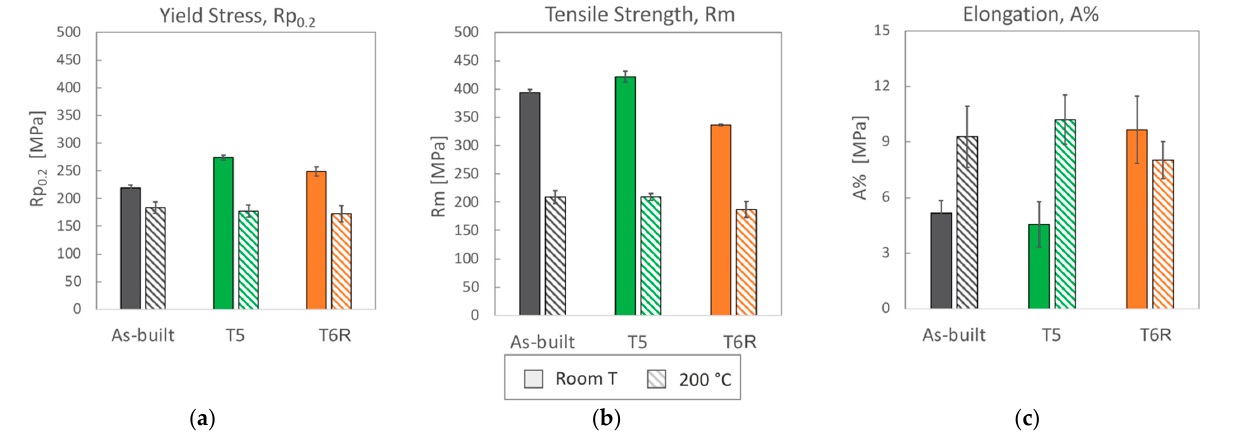
Figure 4. ( a ) Yield stress, ( b ) tensile strength, and ( c ) elongation to failure (mean value and standard deviation) obtained from tensile tests performed at room and high (200 °C) temperature for the as-built, T5, and T6R AlSi7Mg PBF-LB alloy.